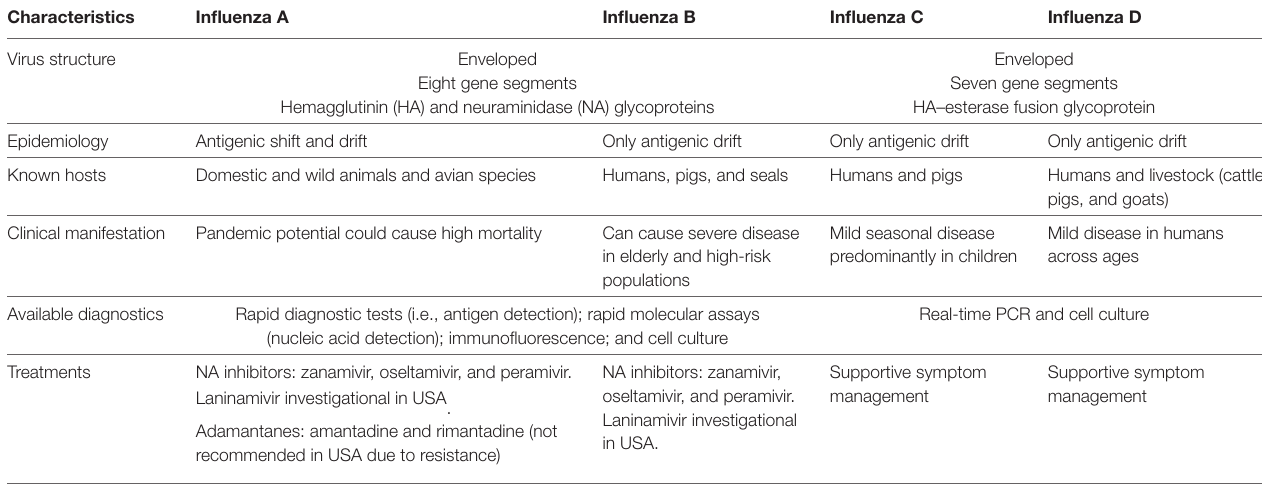
TAbLe 1 | Characteristics of influenza